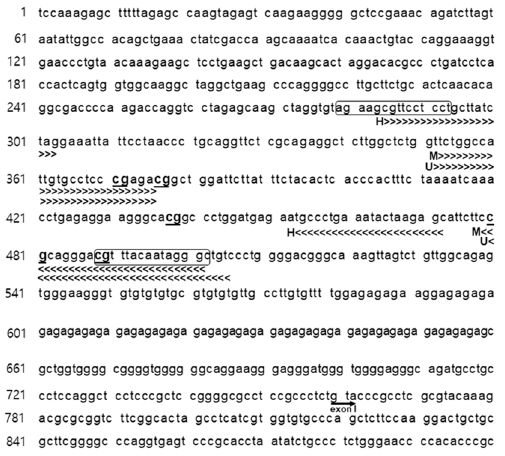
Figure 5. p11 proximal DNA sequence. This sequence represents the promoter region (bases 1–660) and exon I (bases 760 ~) sequence, corresponding to bases 93,554,358–93,555,257 of the NCBI reference